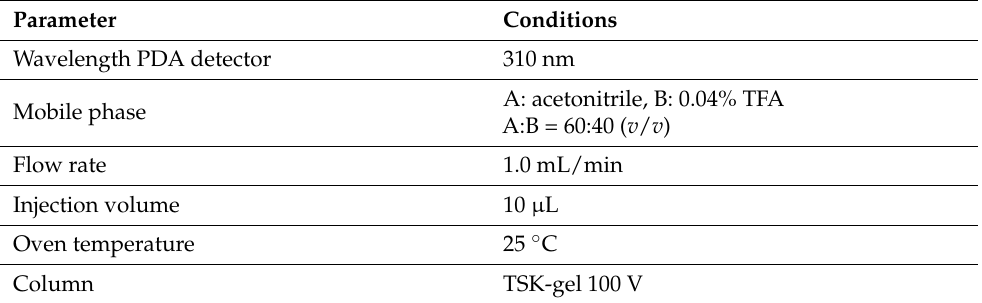
Table 1. Operating conditions of high-performance liquid chromatography (HPLC).